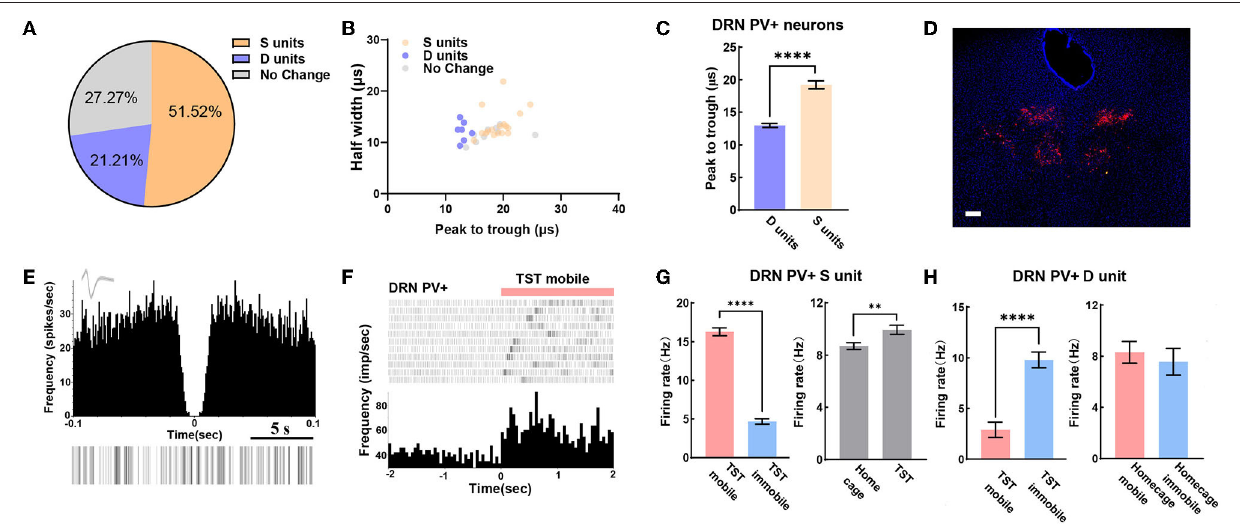
FIGURE 4 | DRN PV + neuronal activity may bidirectional regulate despair-like behaviors. (A) Proportion of different types of units recorded in DRN PV + neurons. N = 8, n = 33, D units = 7, 21.21%; S units = 17, 51.52%. (B) Scatterplot of different units based on their spike waveform of DRN PV + neurons which were identified by optogenetics. (C) Bar pot of peak to trough of putative survival units and despair units of DRN PV + neurons. (D) Sample image showed the injection site of Dio-ChR2-mCherry locations in DRN of PV-Cre mice. Bar, 200 µ m. (E) The autocorrelogram, waveform, and raster of a single PV + neuron recorded in this study, respectively. (F) Spike frequency of an example PV + neuron in DRN from TST immobile to mobile stages. (G) Bar pot of PV + S units in DRN that is activated during TST (right), especially in mobile states (left). (H) Bar pot of PV + D units in DRN that is activated during immobile state in TST (left), but not in home cage (right) (two-tailed unpaired t -test, ** p < 0.01, **** p <